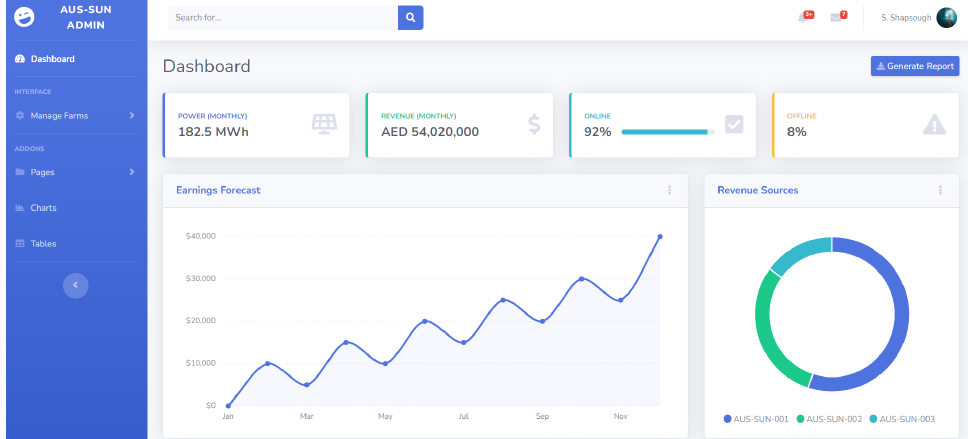
Figure 7. Admin dashboard overview—output and earnings.